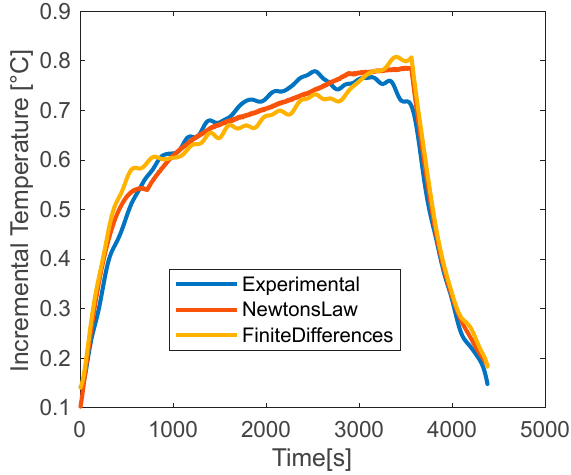
Figure 12. Experimental vs modeled temperature with Newton’s law and finite-differences method for the uncoated battery at discharge rate 0.5C.